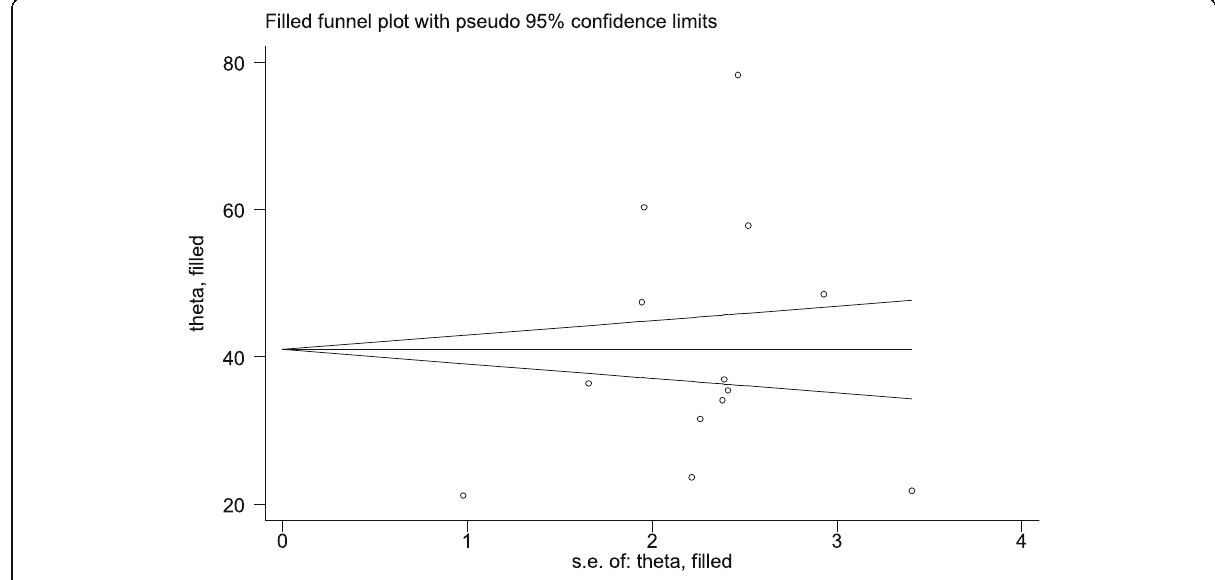
Fig. 6 Trim and fill analysis for correcting publication bias of 13